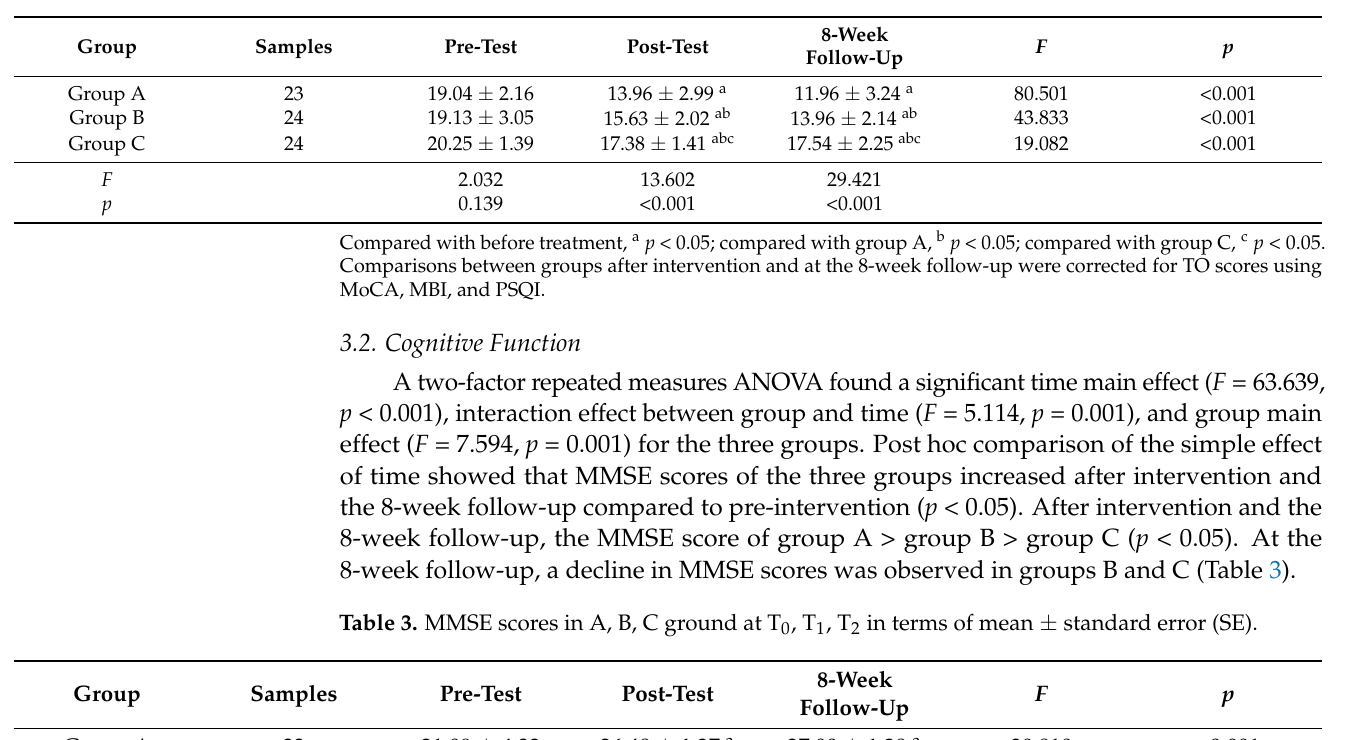
Table 2. HAMD-17 scores in A, B, C ground at T 0 , T 1 , T 2 in terms of mean ± standard error (SE).